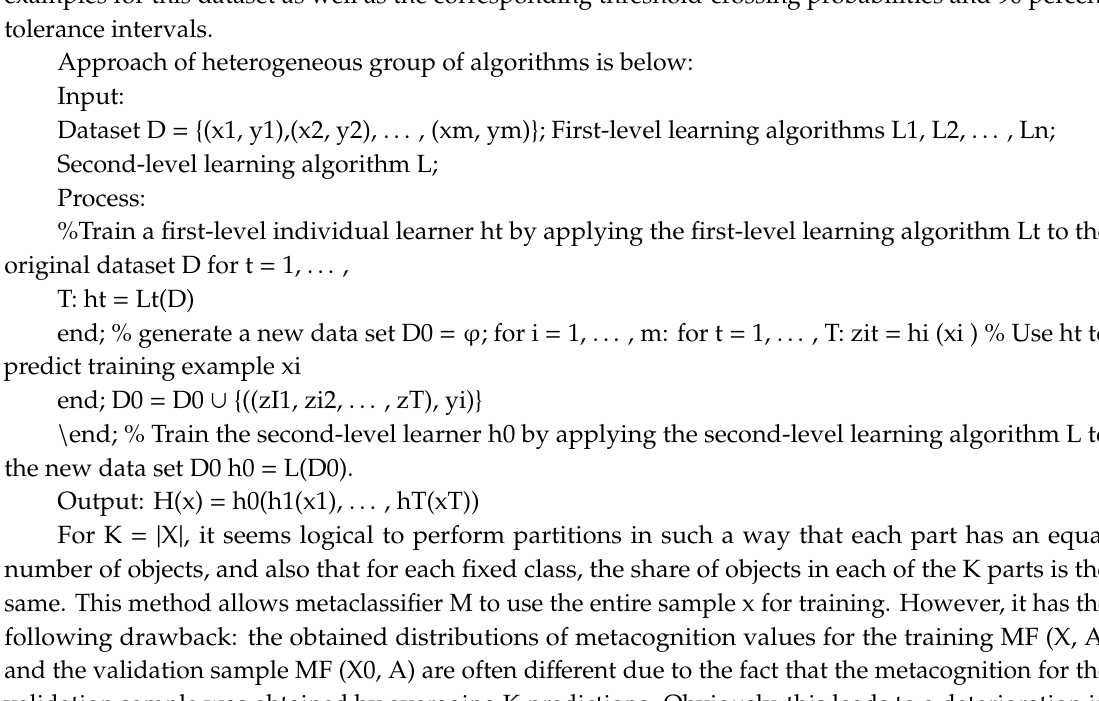
Figure 3. Convergence of the discrepancy of estimates of the transport table .